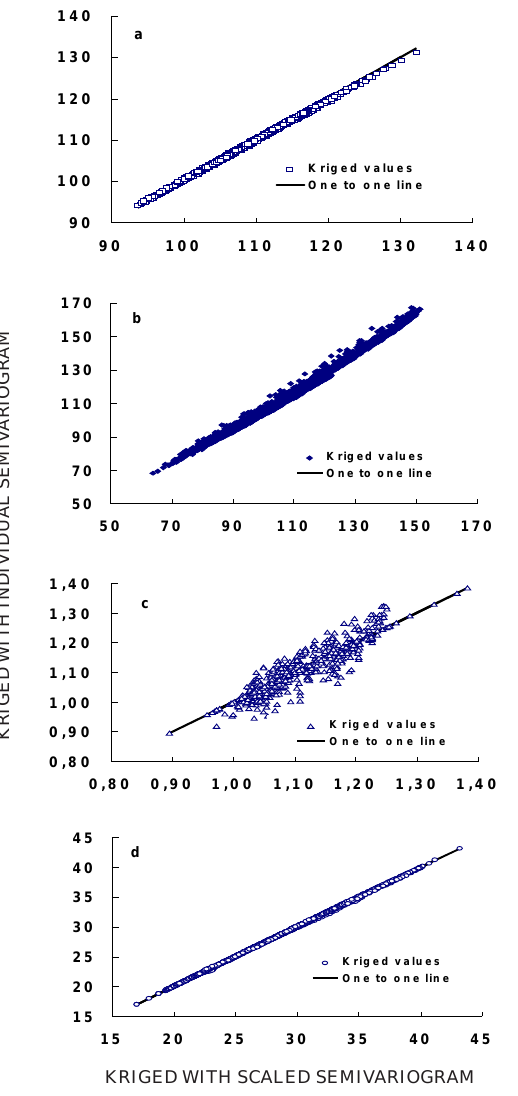
Figure 8. One to one plots. a) Maximum daily rainfall at 10 years return period, São Paulo; b) Cation Exchange Capacity for Dusky Red Latossol, Campinas SP; c) Organic carbon content for Davis soil, Davis CA USA; c) Soil moisture content for 0.2 m depth, Rideau clay loam Ottawa,